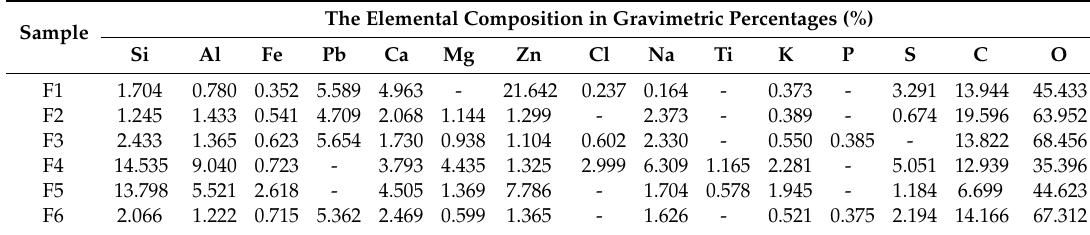
Table 2. The elemental composition of the 6 samples analyzed.